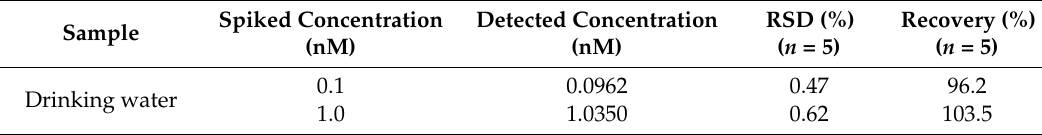
Table 1. Determination of Pb 2+ spiked in drinking water.